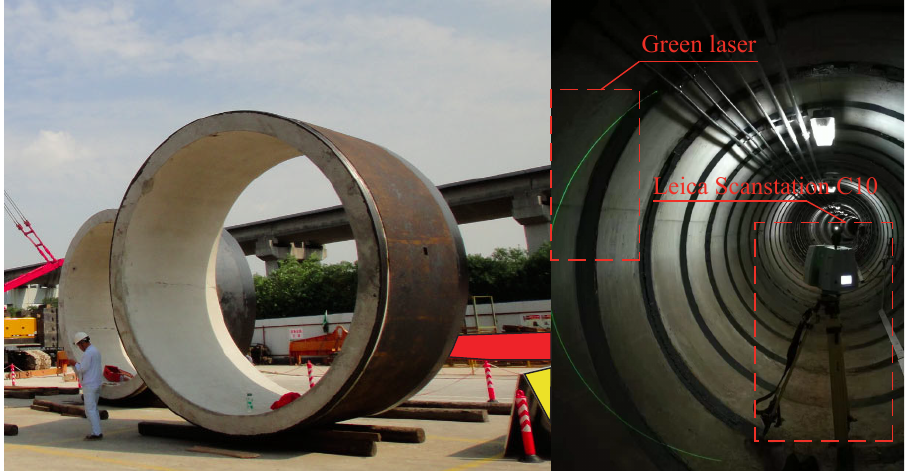
Figure 6. The pipe-jacking circular sewage tunnel lining and Leica Scanstation C10 in the tunnel. The geometric arrangement of scan stations is indicated by Figure 7. ∆ H (m) is defined as the vertical distance from the scan station to the center of the tunnel, and ∆ T (m) is the horizontal distance.